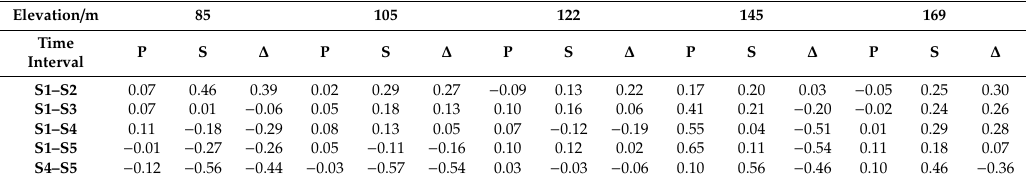
Table 3. Di ff erence between monitoring results at central axis of dam surface obtained by GB-SAR method and reversed pendulum